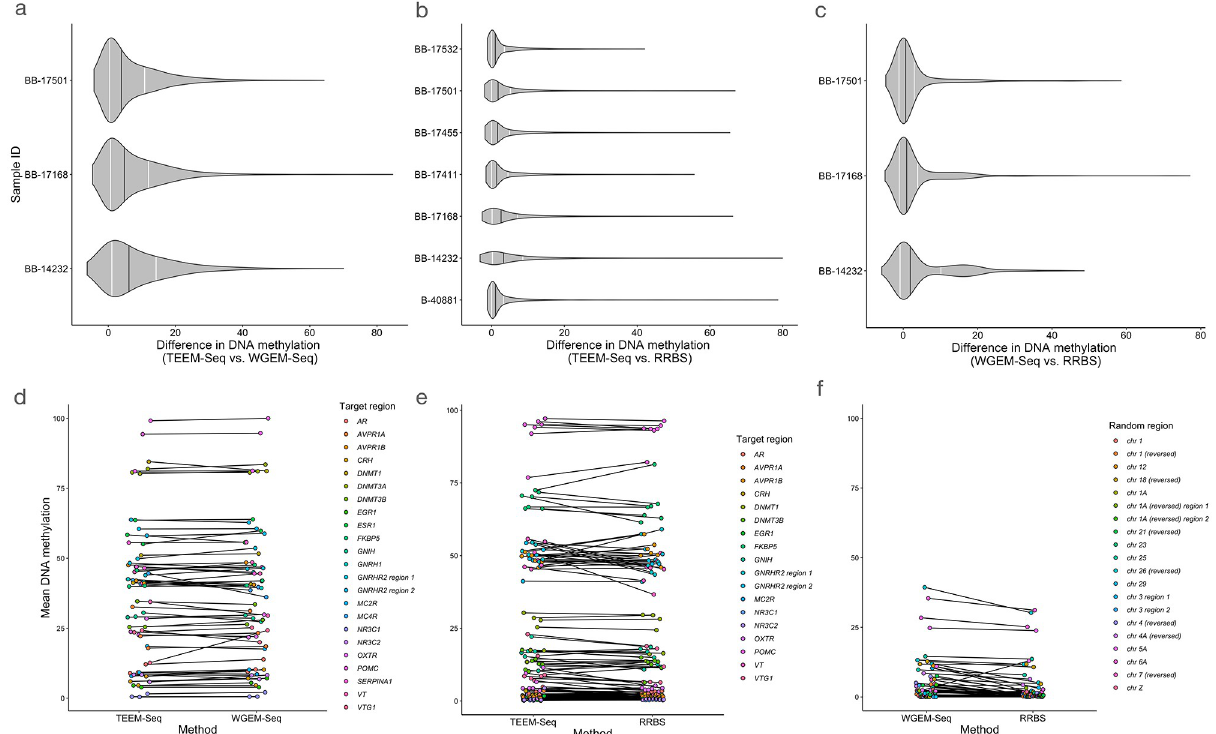
Fig 5. Pairwise comparisons of three methods for quantifying DNA methylation: Target-enriched enzymatic methyl sequencing (TEEM-Seq), whole-genome enzymatic methyl sequencing (WGEM-Seq), and reduced-representation bisulfite sequencing (RRBS). ( a and d ) Libraries for three of the same individual superb starlings were sequenced using both TEEM-Seq and WGEM-Seq. ( b and e ) Libraries for seven of the same individual superb starlings were sequenced using both TEEM-Seq and RRBS. ( c and f ) Libraries for three of the same individual superb starlings were sequenced using both WGEM-Seq and RRBS. WGEM-Seq and RRBS data were compared in 20 random 2.5 kb “promoter” regions that were not included in the bait set because we expected that some RRBS and WGEM-Seq reads corresponding to target ranges might have sparse coverage in comparison to the high coverage bait alignments, and as a valid parallel to check consistency between WGEM-Seq and RRBS outside of target regions. In all cases, there were no differences in DNA methylation among quantification methods, as the absolute value mean differences in DNA methylation for promoter regions and gene bodies or random 2.5 kb “promoter” regions did not differ among pairwise comparisons ( a-c ) In each plot, grey violins show the distribution of CpG site absolute value mean differences in DNA methylation for ( a and b ) promoter regions and gene bodies or ( c ) random 2.5 kb “promoter” regions, black lines depict the median values, and white lines show the 1 st and 3 rd quartiles. Additionally, ( d and e ) mean DNA methylation levels for each target or ( f ) random region did not significantly differ. Target regions are indicated by different colors according to the legends on panels d-f. See S6–S11 Tables for more detailed